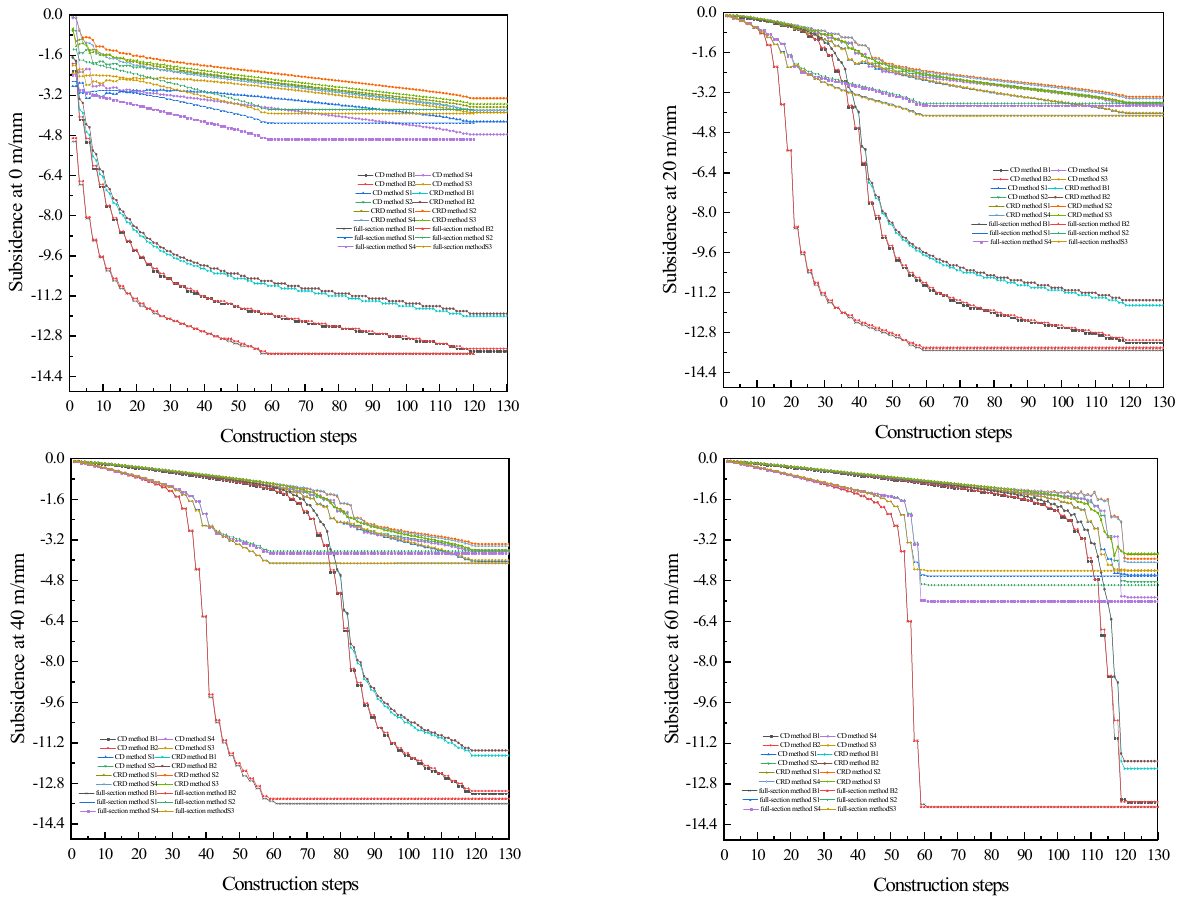
Figure 6. Deformation diagram of tunnels with different excavation methods.